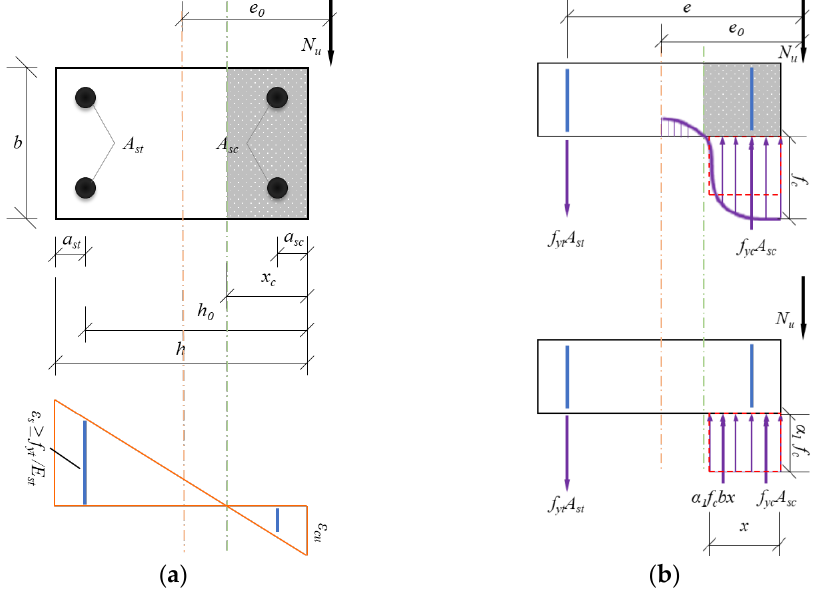
Figure 16. Simplified diagram for calculation of the section subjected to compression failure under large eccentric loading: ( a ) strain diagram of the specimens; ( b ) equivalent calculation diagram.